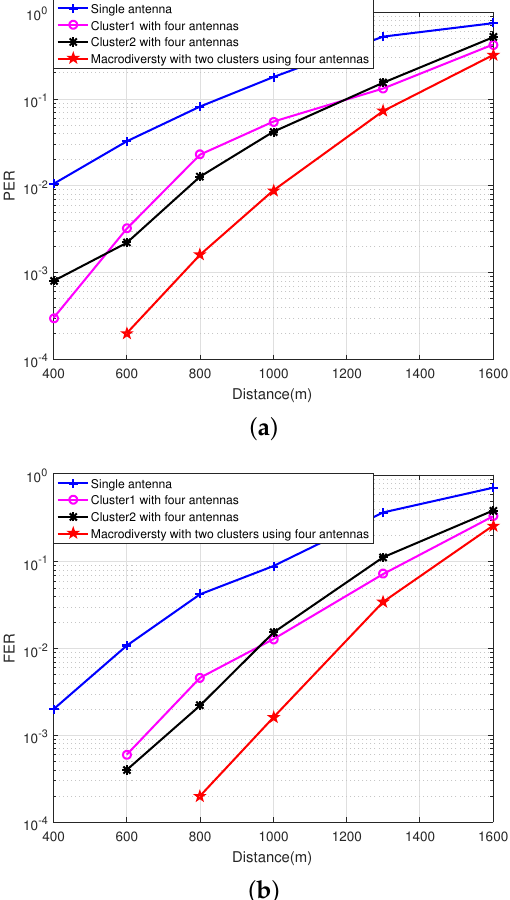
Figure 13. The relationship between performance of macrodiversity reception scheme using different number of antennas and transmission distance. ( a ) The relationship between PER of macrodiversity reception scheme using different number of antennas and transmission distance. ( b ) The relationship between FER of macrodiversity reception scheme using different number of antennas and transmission